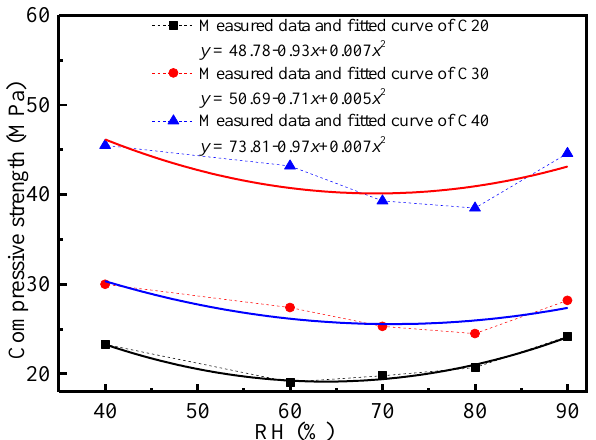
Figure 4. Relation curve between the compressive strength of concrete and relative humidity.